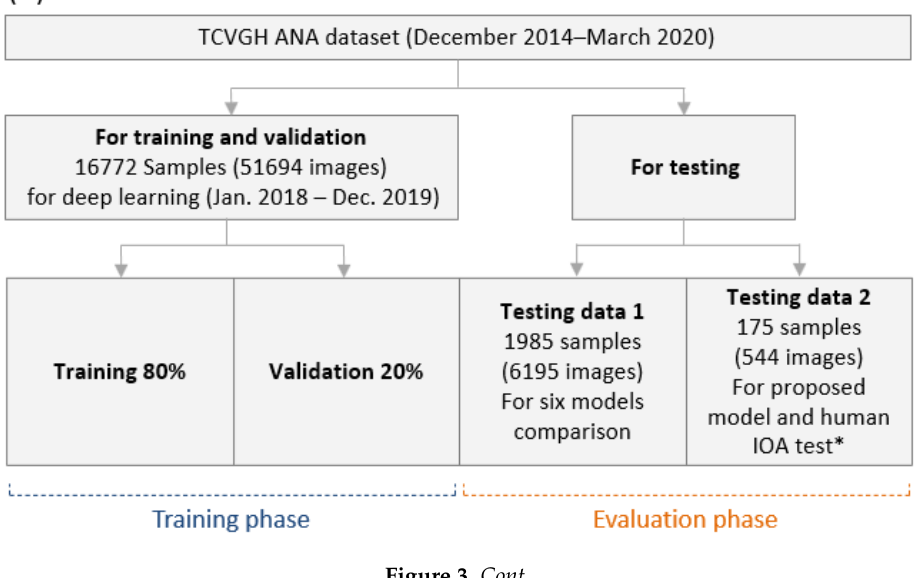
Figure 3. ( A ) Schematic depiction of dataset in this study for training phase and evaluation phase. ( B ) The overall convo- lutional neural network (CNN) architecture of the proposed model (InceptionResNet V2) for ANA mixed patterns classi- fication. TCVGH = Taichung Veterans General Hospital; CNN = convolutional neural network; IOA = inter-observation agreement; * among five experienced-certified medical technologists, two new rheumatology fellows-in-training and the proposed model. 2.8. From Image Prediction to Sample Prediction Each ANA sample yielded at least three images to ensure that there were sufficient metaphase cells identified by the NOVA view machine. As the ultimate aim was to apply supervised machine learning in clinical practice, we adopted a modified voting approach to comprehensively evaluate the predictive results of all images in each sample. For each HEp-2 cell image, a probability distribution was generated by the pre-trained model